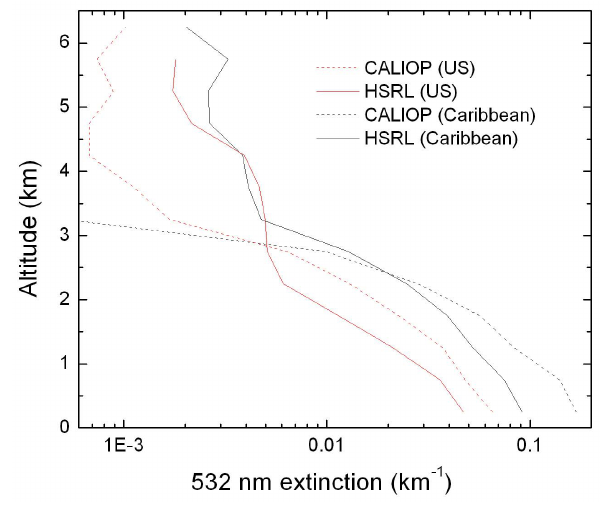
Fig. 14. Comparison of seasonally averaged Aeronet and CALIOP AOD data in two clean marine regions.